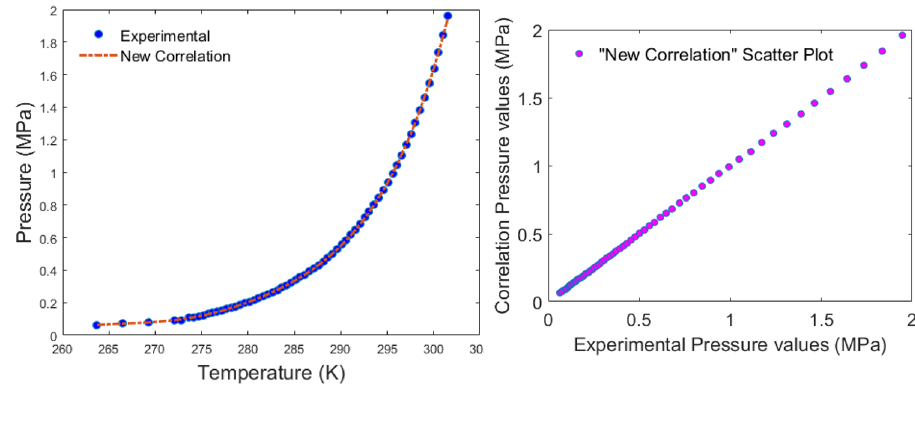
Table 14 The constants determined with n = 1.6*